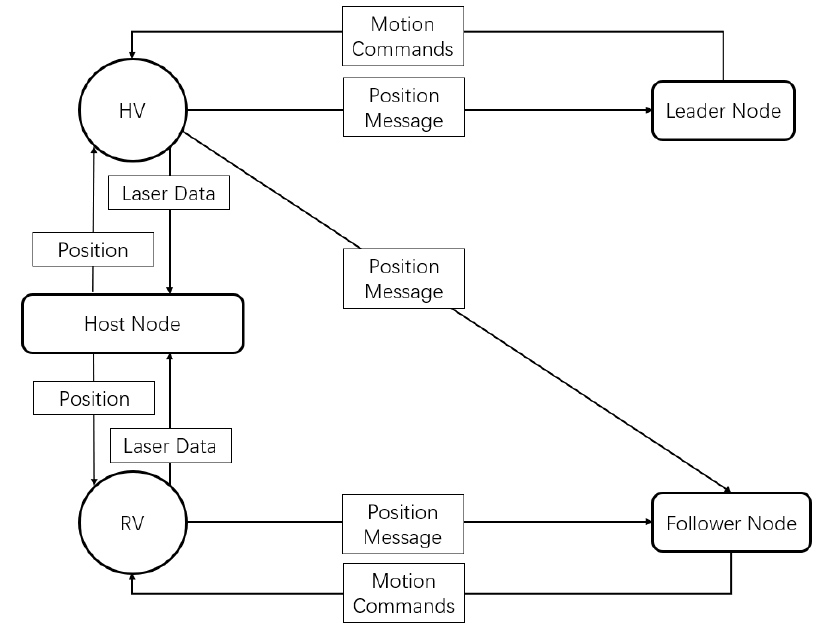
Figure 2. Leader–follower system framework.